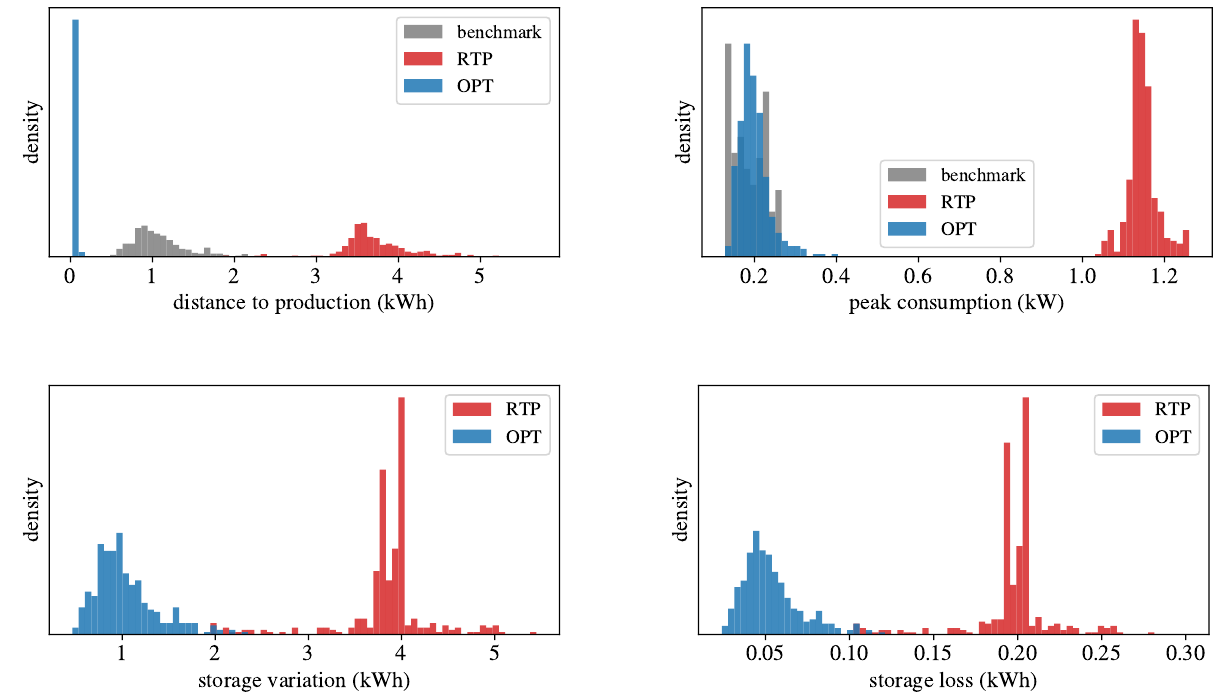
Figure 4. Histograms of indicator values for S max = 2.0.